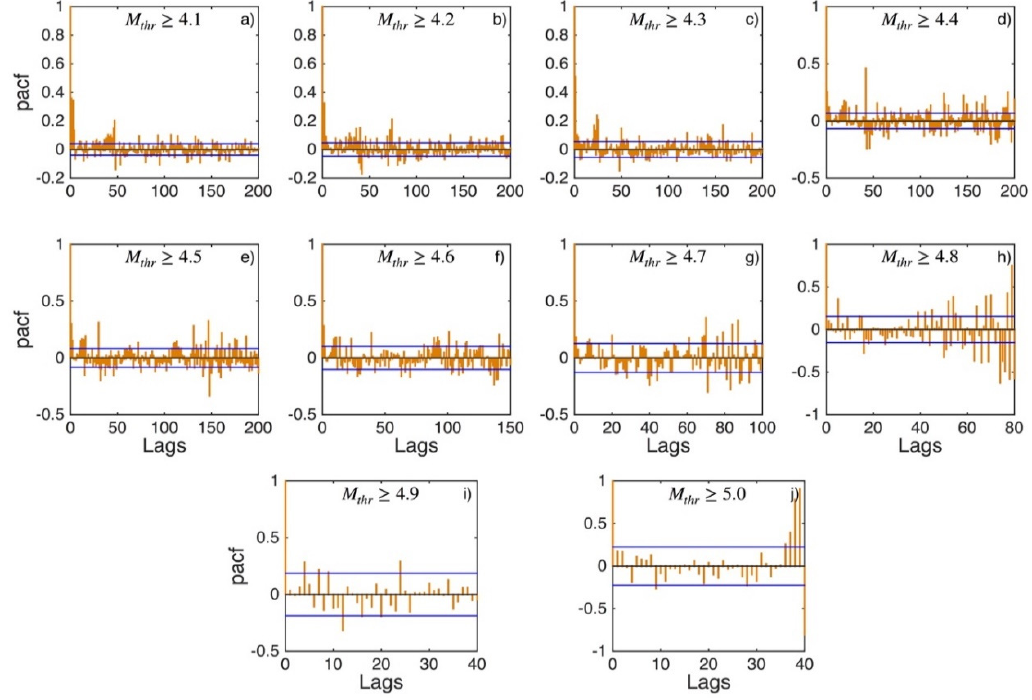
Figure A11. PACF values (orange stems) and their 95% confidence intervals (blue lines) for Southeast Aegean Sea (sub − area 5) for magnitude thresholds ( M thr ) varying from 4.1 to 5.0 (subplots a – j ).